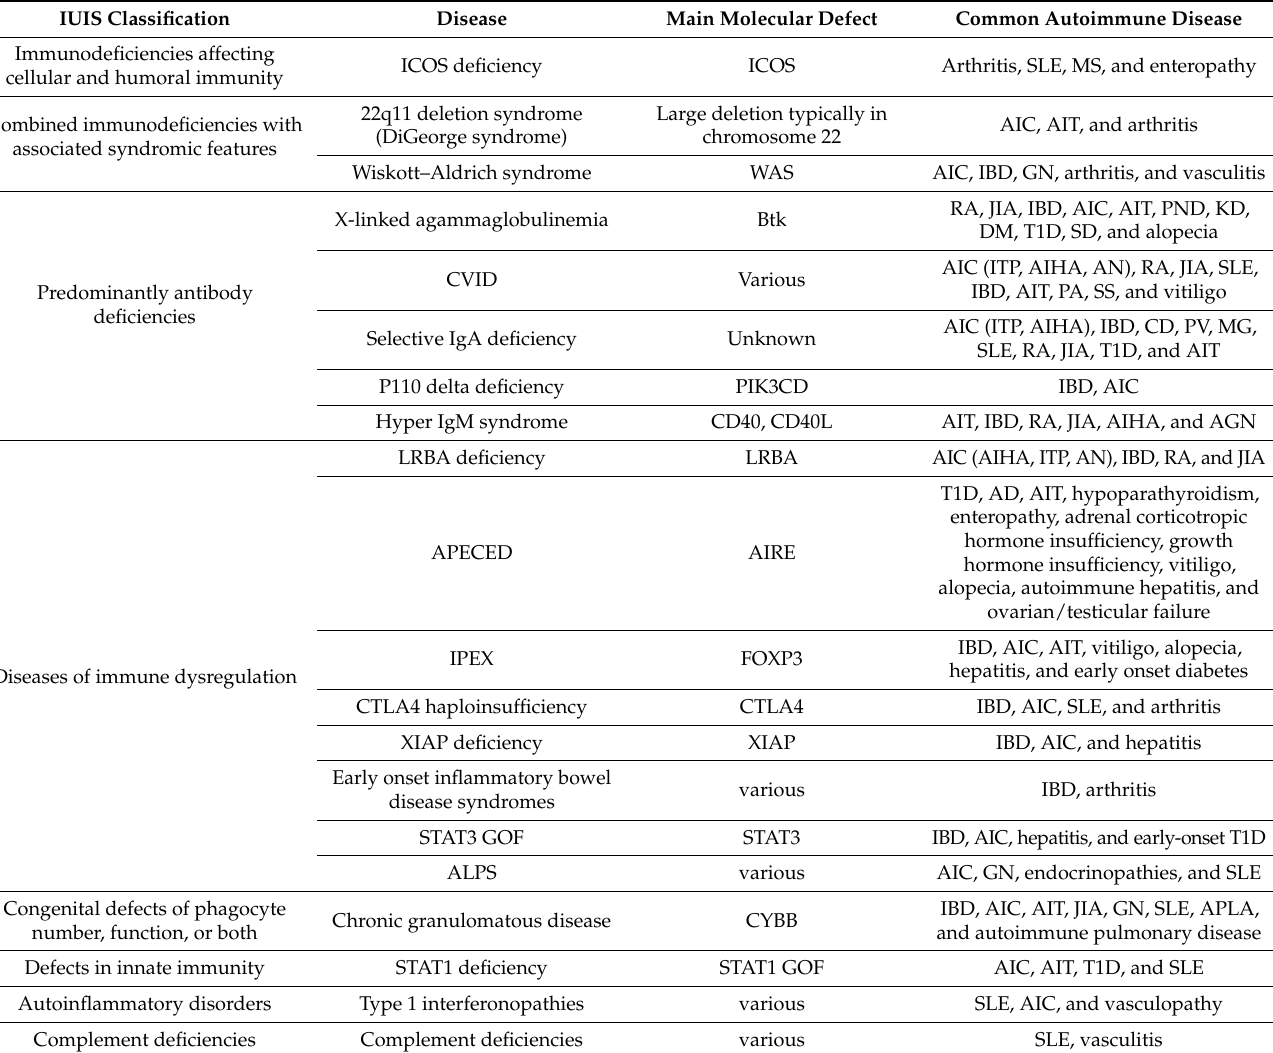
Table 2. Common autoimmune presentation in inborn errors of immunity